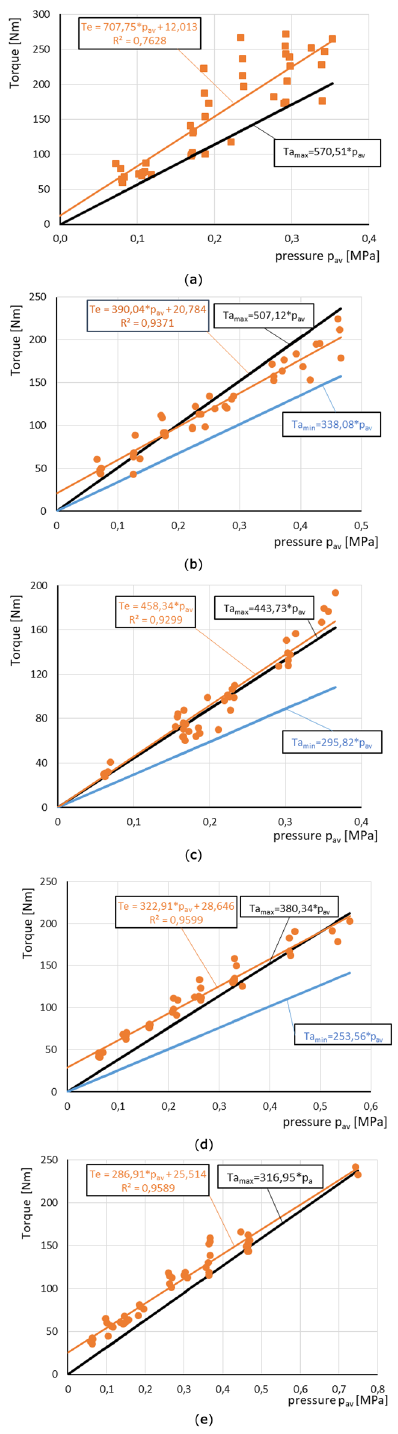
Figure 12. Comparison of torque transmitted by a clutch package formed by discs with different thicknesses as a function of mean value of contact pressure: D i = 80 mm, D o = 115 mm. Number of friction surfaces: ( a ) 18; ( b